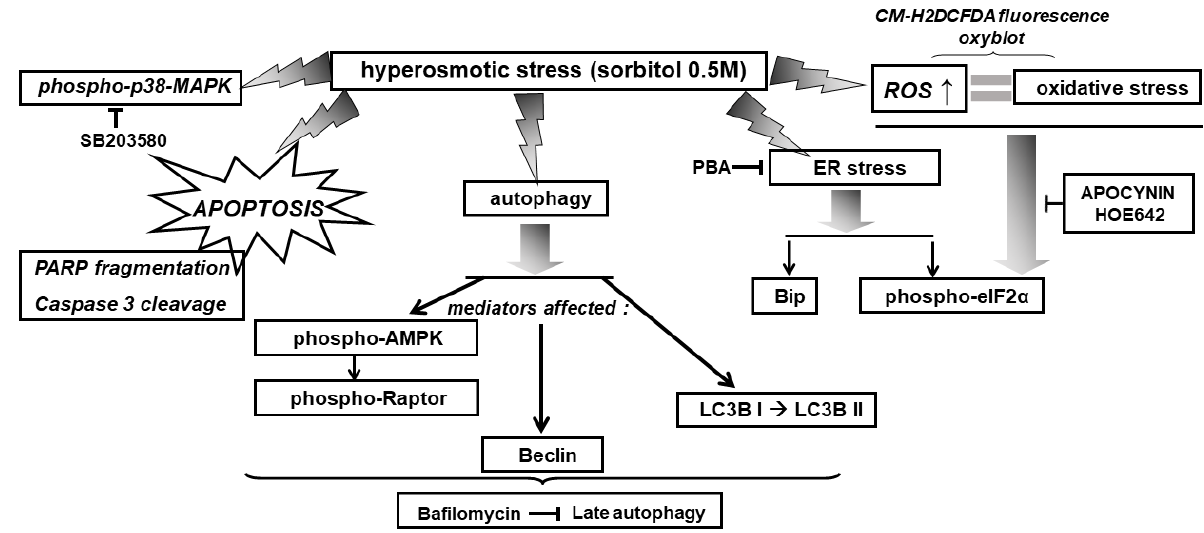
Figure 14. Schematic diagram of a model illustrating the diverse signaling mechanisms triggered by hyperosmotic stress in H9c2 cells, with emphasis on the effectors activated, mediating the observed responses. → activation, ˧ inhibition.